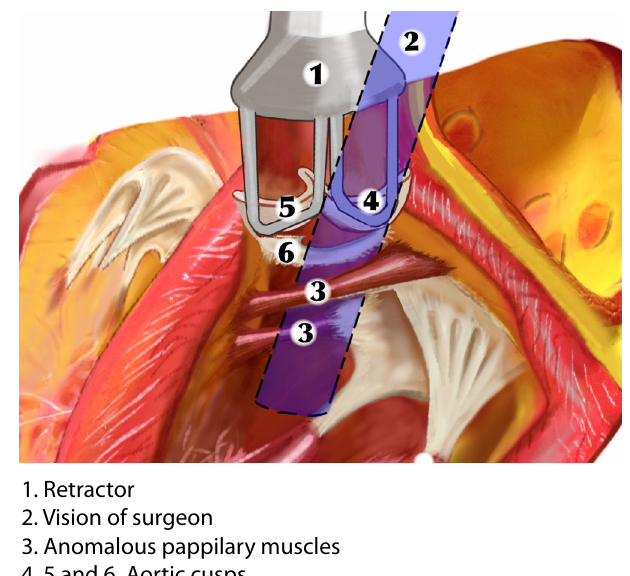
Fig. 4 - Schematic drawing. Vision of the